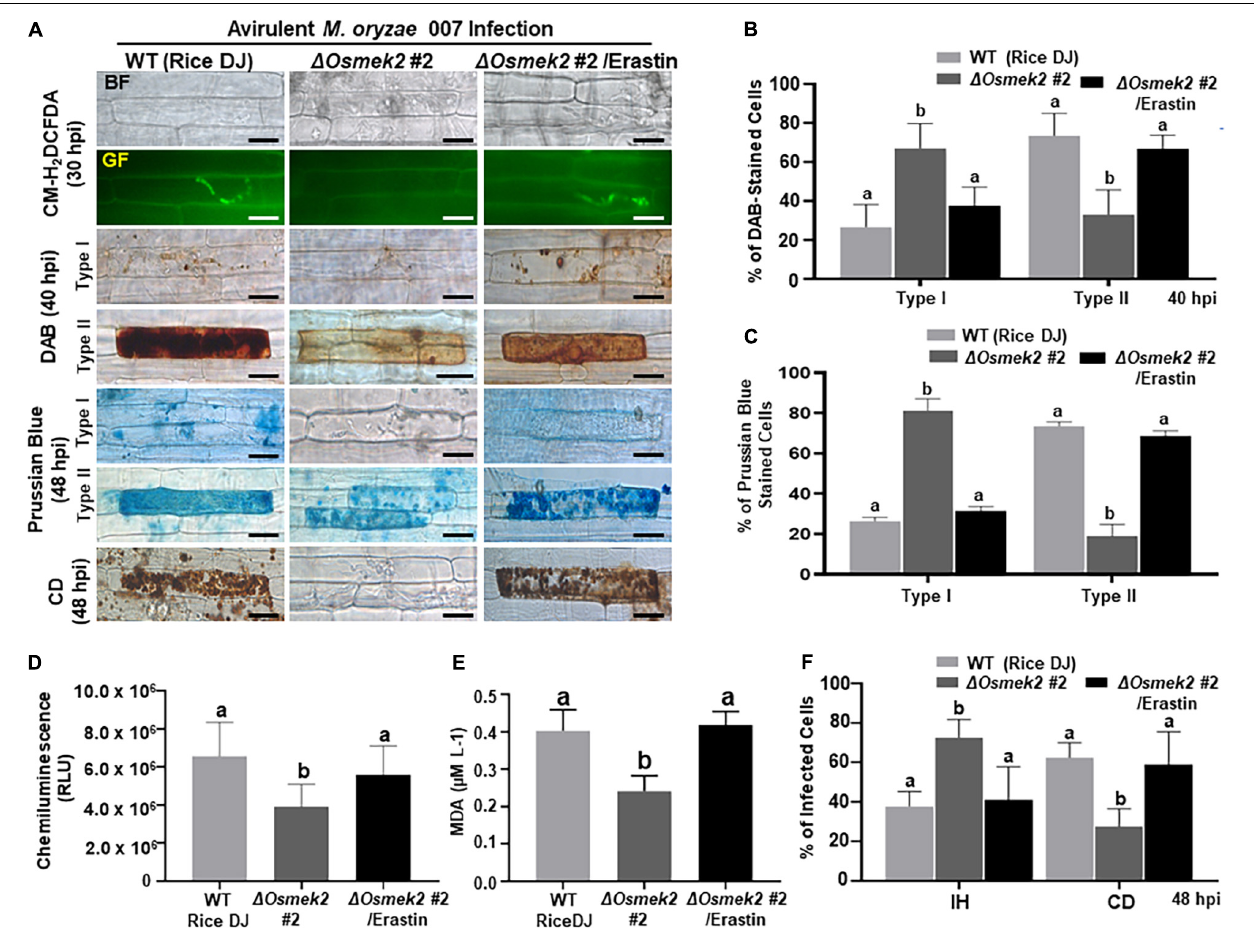
FIGURE 6 | The small molecule inducer erastin triggers iron- and ROS-dependent ferroptotic cell death in the compatible (cid:49) Osmek2 – Magnaporthe oryzae interaction. Leaf sheaths of WT rice DJ and (cid:49) Osmek2 #2 knock-out plants were inoculated with conidial suspensions (4 × 10 5 conidia/mL) of M. oryzae 007 containing 10 µ M erastin. (A) Erastin treatment recovered ROS and ferric ion (Fe 3 + ) accumulation and cell death in leaf sheaths of (cid:49) Osmek2 #2 plants during avirulent M. oryzae 007 infection. ROS accumulation in leaf sheath epidermal cells was detected by CM-H 2 DCFDA (green fluorescence) and DAB (dark brown color) staining. Prussian blue (blue color) staining shows ferric ion accumulation in rice cells. The images are representative of different leaf sheath samples from three independent experiments. Scale bars = 20 µ m. (B) DAB-stained cell phenotypes. DAB-stained cells were divided into two phenotypes: Type I, cells that contain invasive hyphae (IH) but are weakly or not DAB-stained; and Type II, strongly DAB-stained cells with only a few poor hyphae. (C) Quantification of Prussian blue-stained cells. Prussian blue-stained cells were divided into two phenotypes: Type I, cells that contain invasive hyphae (IH) but are weakly or not Prussian blue-stained; and Type II, strongly Prussian blue-stained with only a few poor hyphae. (D) Quantification of ROS accumulation. ROS accumulation was monitored using a GloMax R (cid:13) 96 Microplate Luminometer (Promega). Values are means ± SD of total relative luminescent units (RLU) ( n = 10). (E) Determination of lipid (MDA) peroxidation in leaf sheaths at 48 h after inoculation. Results are presented as means ± SD; n = 4 leaf sheaths from different plants. (F) Quantification of infected cell phenotypes in rice leaf sheaths. Images were taken using a fluorescence microscope (Zeiss equipped with Axioplan 2) with bright field and green fluorescence (GF) filters. Experiments were repeated three times with similar results. Results are presented as means ± SD; n = 4 leaf sheaths. Different letters above the bars indicate significantly different means ( P < 0.05), as analyzed by Fisher’s protected least significant difference (LSD) test. IH, invasive hyphae; CD, cell death; BF, bright field; GF, green fluorescence; hpi, hours